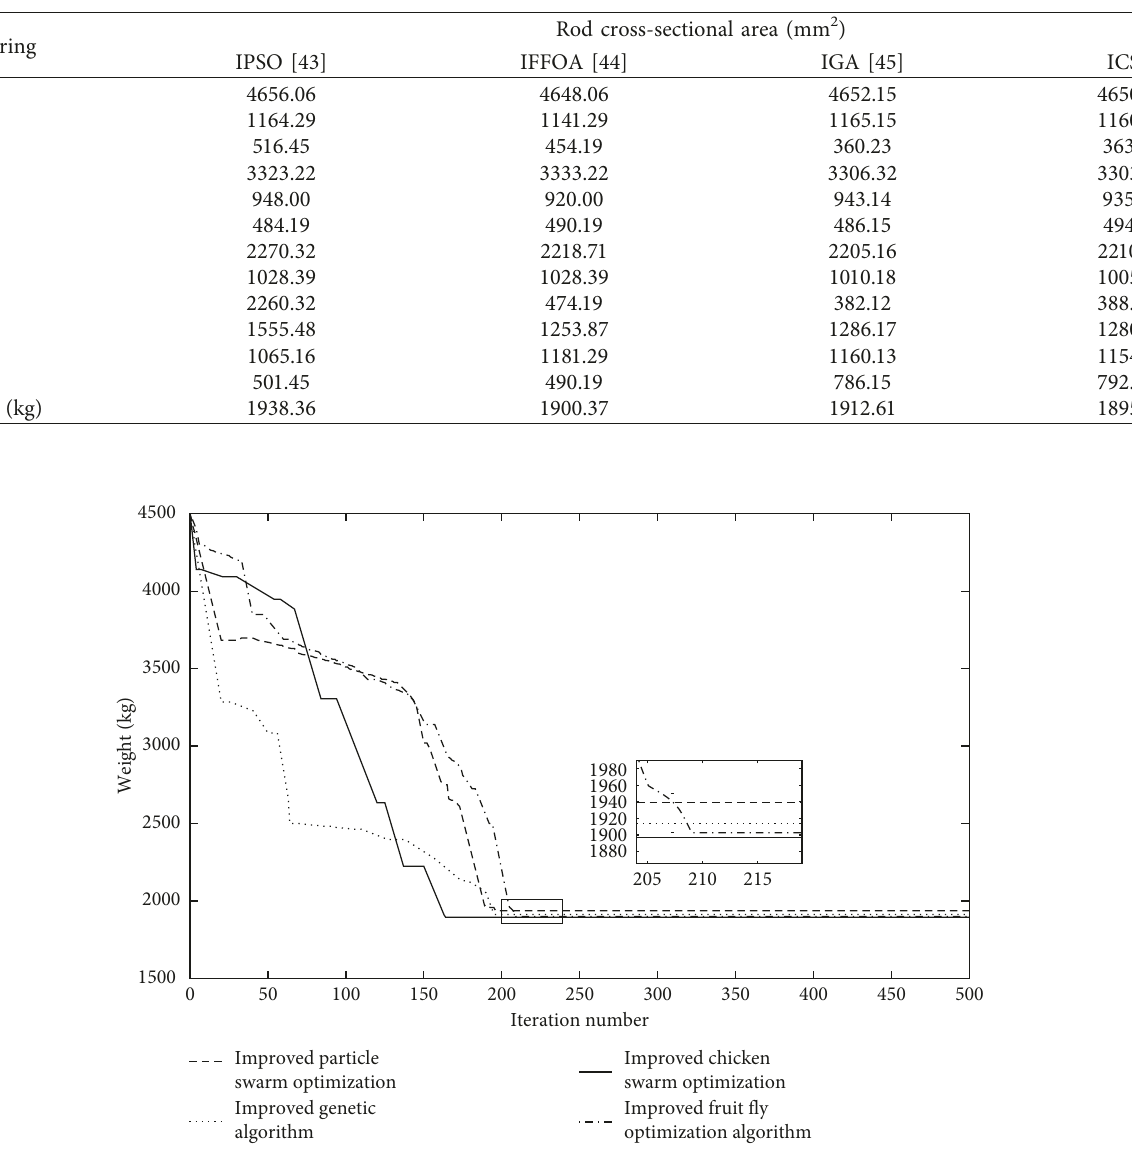
Table 8: Comparison of optimization results of the 52bar plane truss structure.